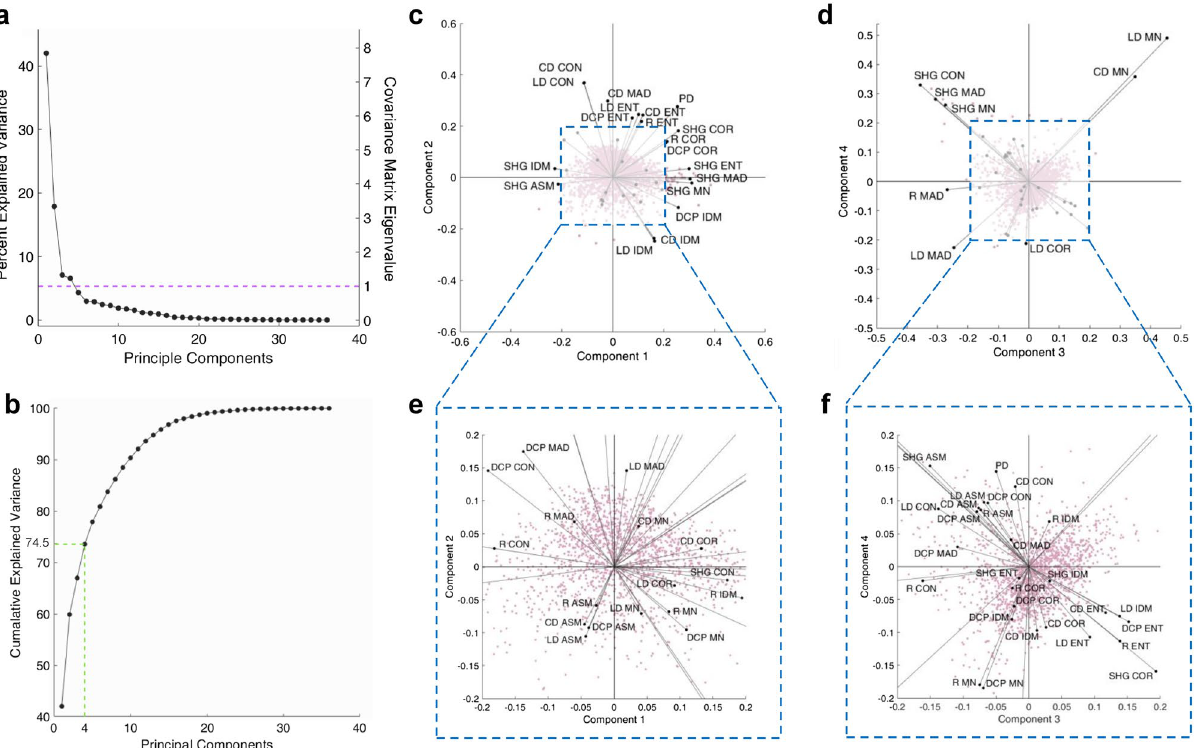
Figure 2. Principal components analysis. Percent explained variance depicts a clear elbow at PC4, also corresponding to covariance matrix eigenvalue of 1 (purple dashed line), below which, the principal components possess less distinctive features than the original dataset ( a ). The cumulative explained variance shows that first 4 PCs account for 74.5% of the variance in the data ( b ). Biplots of PC2 vs PC1 ( c ) and PC4 vs PC3 ( d ), and their insets ( e , f , respectively), show the most significant contributing polarimetric and texture parameters in each PC. Acronyms: PD pixel density, SHG SHG intensity, R R-ratio, DCP degree of circular polarization, CD SHG-CD, LD SHG-LD, CON contrast, COR correlation, ENT entropy, ASM angular second moment, IDM inverse difference moment, MN mean, MAD mean absolute form of linear combinations of the original dataset, referred to as principal components (PCs) 36 . As shown in Fig. 2a, the first 4 PCs possess the most useful information, as indicated by the dashed purple line correspond- ing to covariance matrix eigenvalue of 1. Eigenvalues of the covariance matrix depict the variance of data in the principal component basis, and according to the widely adopted Kaiser Criterion, covariance matrix eigenval- ues less than 1 contain less variability compared to the original parameters and may be disregarded in further considerations 37 . The first 4 PCs also explain 74.5% of the variance in the data (Fig. 2b), while the first 2 PCs explain 42% and 19% of the total data variance, respectively. Therefore, we concluded that only the first 4 PCs may be utilized in unsupervised machine learning. Biplots of PC2 vs PC1 and PC4 vs PC3 allows for visualization of the extent of contribution of polarimetric and texture parameters in the 4 most important PCs, as shown in Fig. 2c,d. In biplots, the relative proportion of parameters in a given PC can be visualized with projection of the length (loading) of the eigenvectors onto the corresponding PC axis. As such, it was evident that largest contributors to PC1, and thus over 40% of the variance in the data, was mostly associated with SHG intensity and pixel density. In addition, R-Ratio and DCP correlation and IDM played an important role in separating the data. As a result, we considered PC1 to mostly represented morphological and molecular variations in the tissue. The most important factors of PC2 were SHG-CD and SHG-LD contrast and IDM, and entropy of most polarimetric parameters, which provided ample information regarding heterogeneity and disorder of collagen fiber orientation and organization. Moreover, it was clear that both and PC3 and PC4 correspond mostly to SHG intensity contrast, mean, and MAD, as well as SHG-CD and SHG-LD mean. Insets of the dashed blue bordered sections are provided for each biplot in Fig. 2e,f, showcasing the eigenvectors of the parameters with less significant contribution to the top 4 PCs. On the whole, we conclude that pixel density and SHG intensity with its associated texture parameters result in the most apparent variance in the data. As the tissue undergoes morphological changes due to the presence of tumor, degradation of colla- gen, or alternatively, the initial stages of fibrosis result in the appearance of collagen fragments which contribute less efficiently to the produced SHG signal. In addition, collagen fiber heterogeneity and disorder seem to cause significant variation in the data, as indicated by SHG-CD and SHG-LD contrast, IDM, entropy, as well as, DCP and R-Ratio entropy. Due to large area of the imaged tissue and the complexity of collagen organization, such